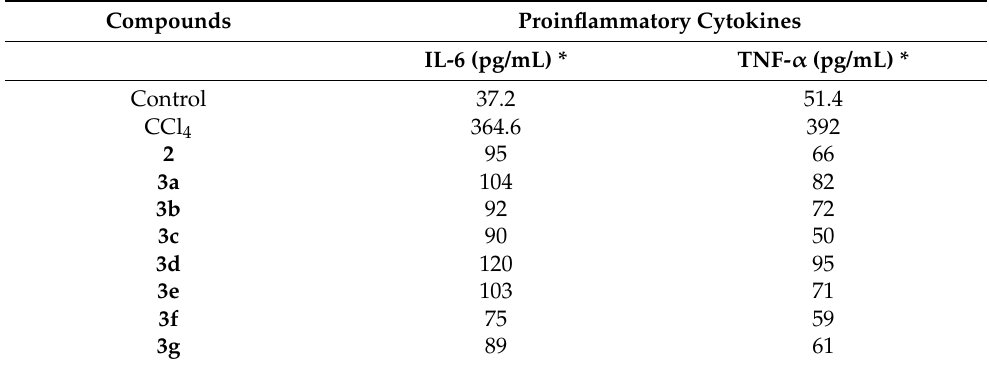
Table 2. The IL-6 and TNF- α (pg/mL) activity of the tested compounds 2 , 3a – g as anti-inflammatory. Compounds Proinflammatory Cytokines IL-6 (pg/mL)